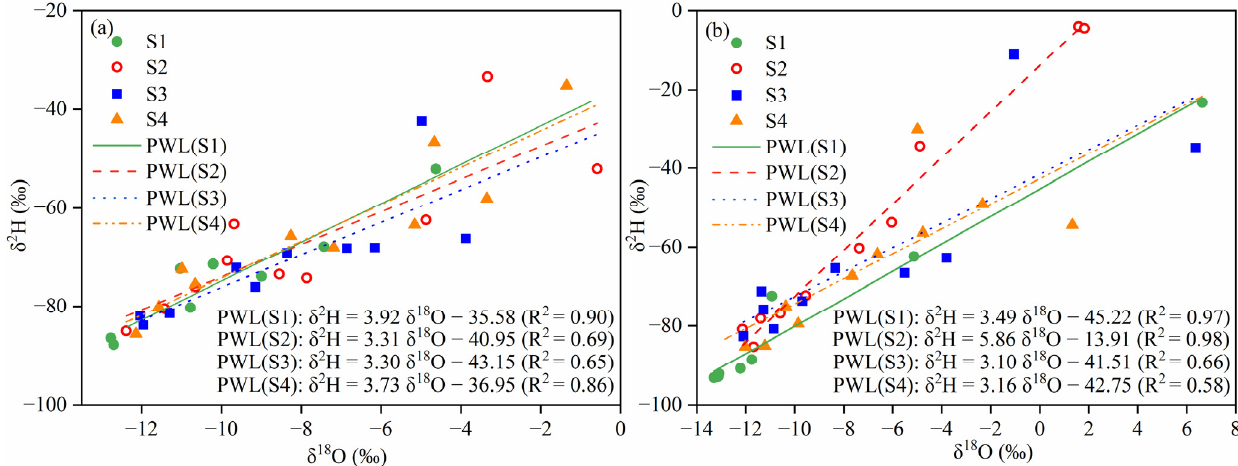
Figure 5. The isotope compositions ( δ 2 H and δ 18 O) of potential water sources (soil water in different layers and groundwater) at four sample sites (S1, S2, S3, and S4) during June 2022 ( a ) and July 2022 ( b ). The PWL for site S1 was fi tt ed from 8 water sources (7 soil water data and 1 groundwater data), and the PWL for sites S2 to S4 were fi tt ed from 10 water sources (9 soil water data and 1 groundwater data) . 1